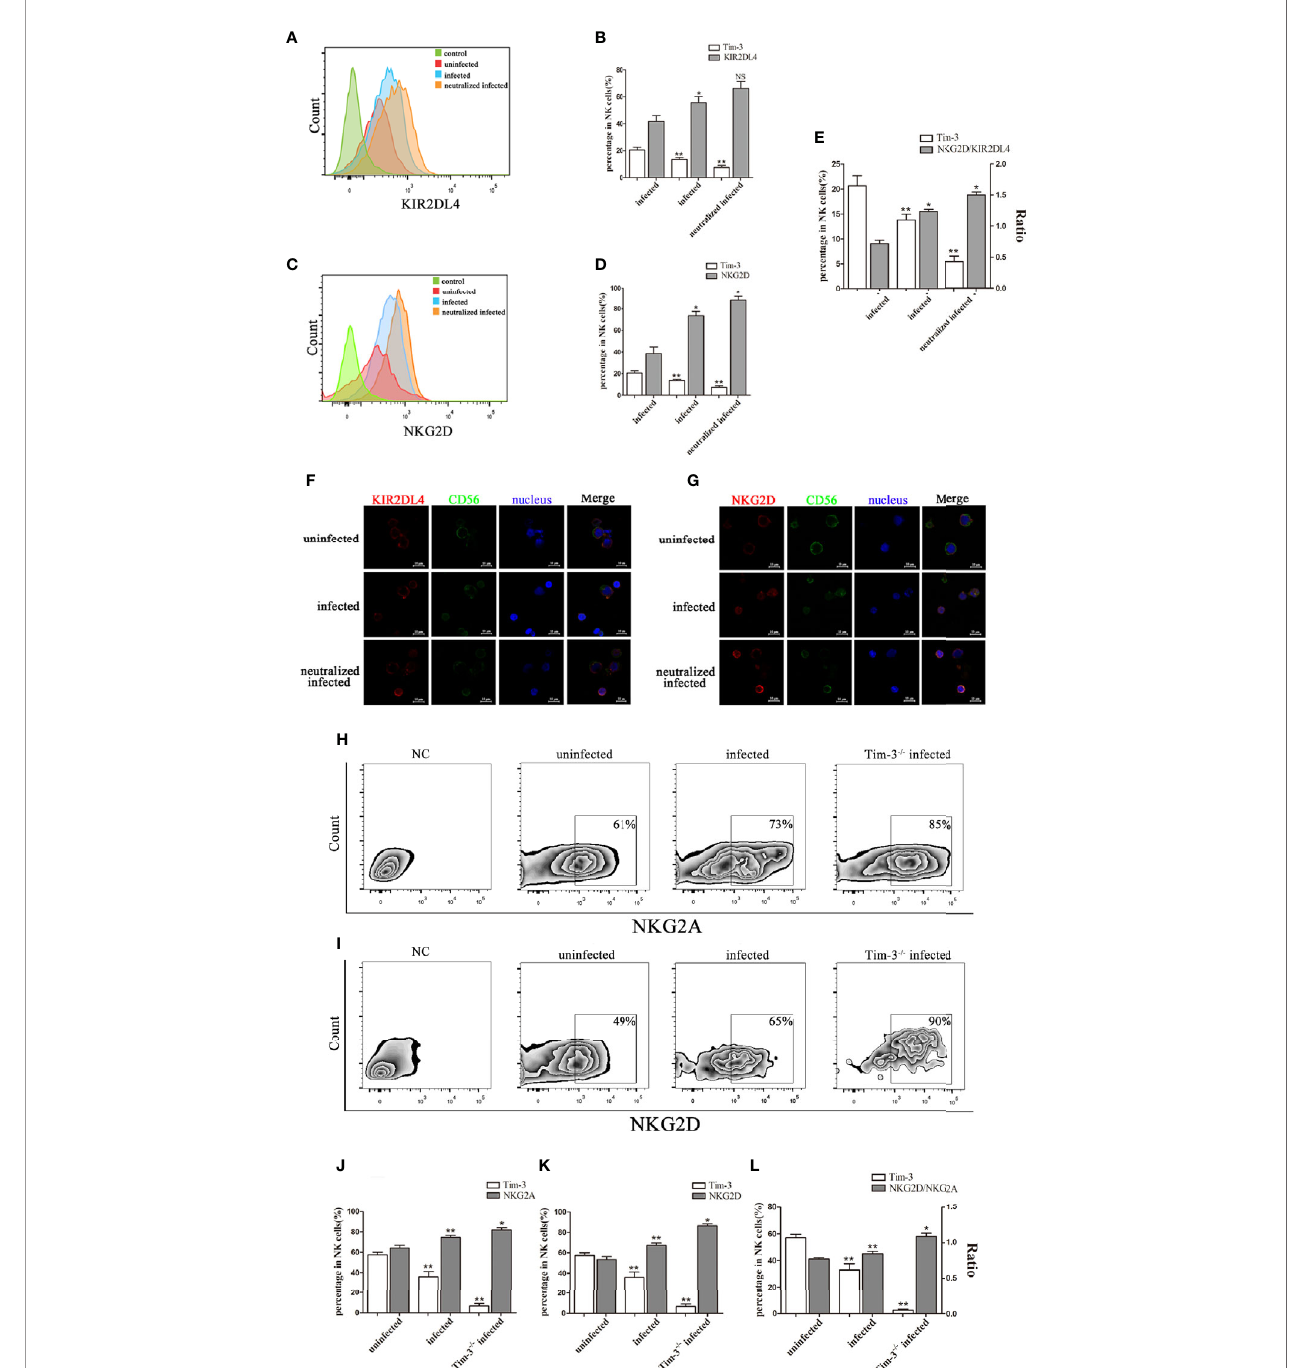
FIGURE 3 | Reduction of Tim-3 expression by T. gondii infection is associated with the imbalance of inhibitory and activating receptors on dNK cells. (A, C) Flow cytometry analysis revealed that expression of Tim-3, KIR2DL4, NKG2D on human dNK cells were altered in uninfected, infected, and anti-Tim-3 neutralized infected cells from patients who underwent induced abortion. (B, D, E) Statistical analysis of Tim-3, KIR2DL4 and NKG2D expression and ratios of NKG2D/KIR2DL4 on human dNK cells among three groups. (Means ± SD; N=6 human samples per group, * p < 0.05, ** p < 0.01, by unpaired t -test. NS, Not Statistically Signi fi cant) (F, G) Representative immuno fl uorescent photographs of KIR2DL4 (red), CD56 (green) and NKG2D (red) expression in uninfected, infected, and anti-Tim-3 neutralized infected human dNK cells. Nuclei (blue) were stained by 4 ’ , 6-diamidino-2-phenylindole. Representative expression changes of inhibitory receptor NKG2A. (H, J) and activating receptor NKG2D (I, K) on mice dNK cells from uninfected, infected and Tim-3 -/- infected mice. (L) Histogram analysis of Tim-3 and ratios of NKG2D/NKG2A in three groups. (Means ± SD; N=8 mice per group, in vivo , * p < 0.05, ** p < 0.01, by unpaired t